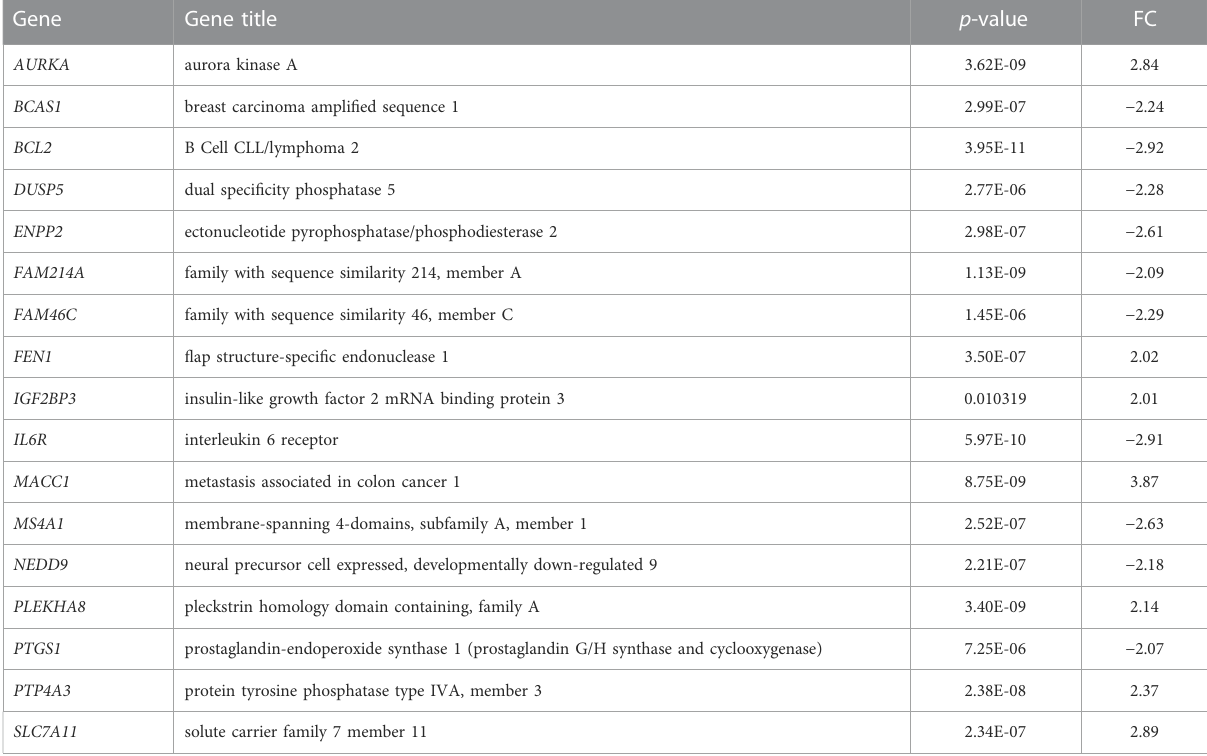
TABLE 1 The 17-gene signature that is identi fi ed in this study for CRC.